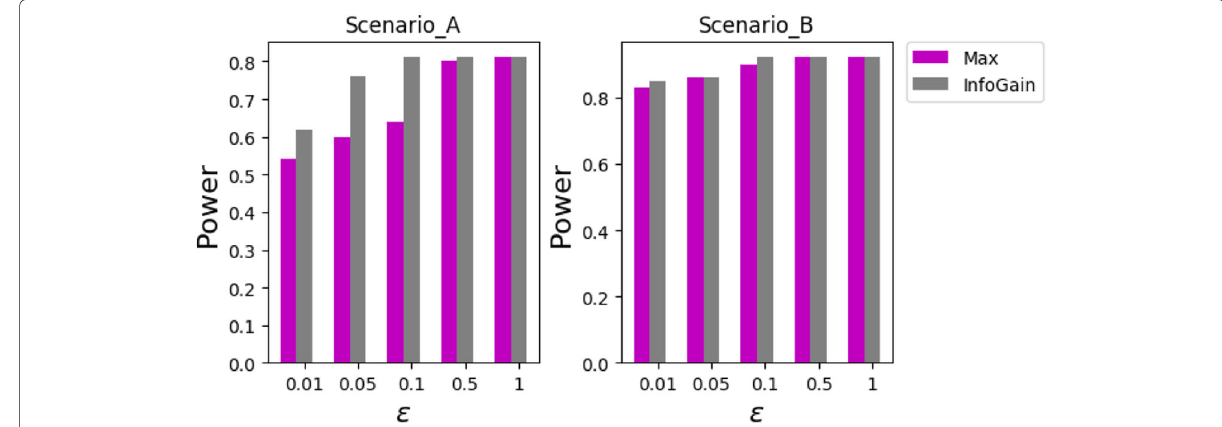
Fig. 6 020501_3( MAF = 0.2, λ = 0.5, r 2 = 1), L = 2